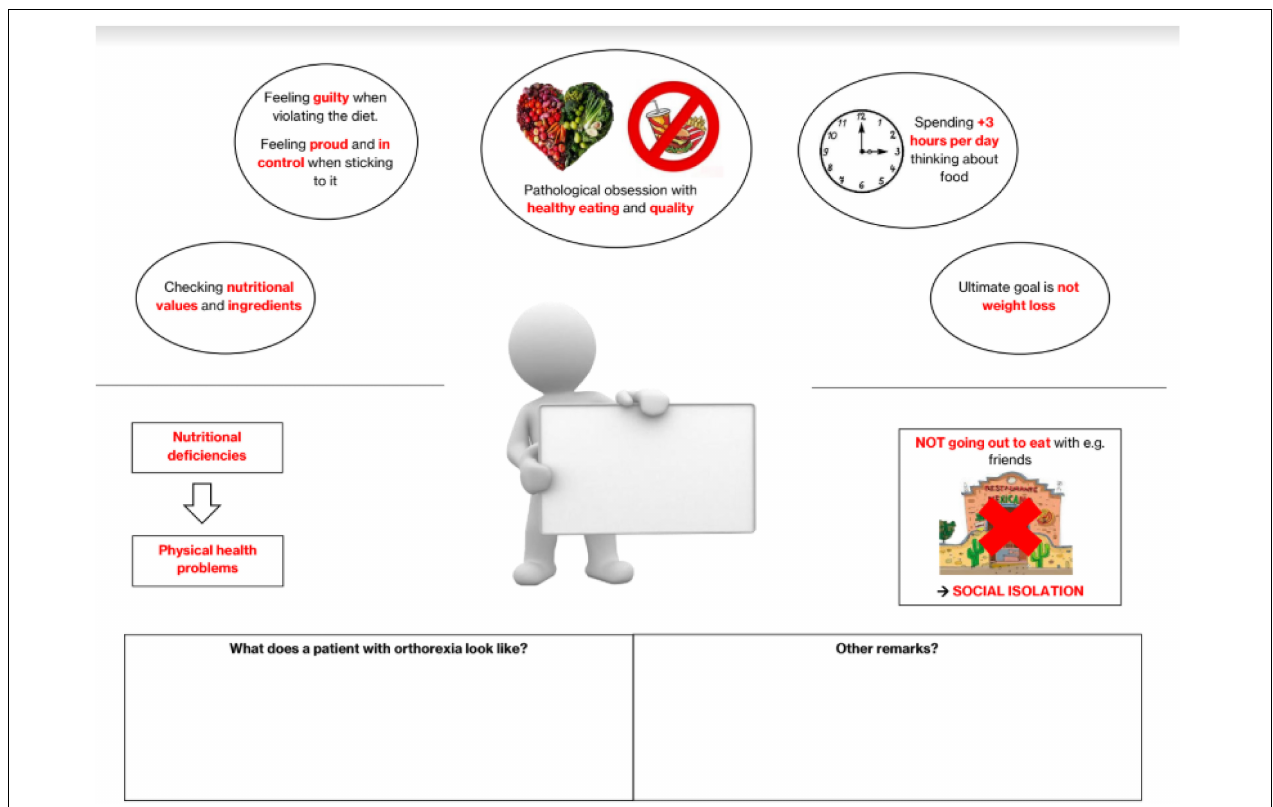
FIGURE A1 | Schematic representation of an individual with ON-related symptoms used during